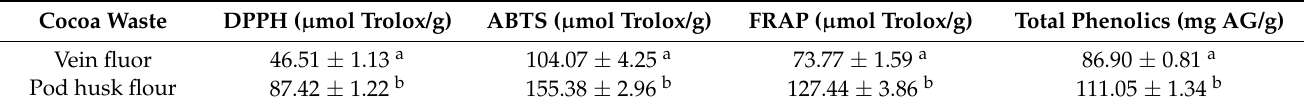
Table 6. Antioxidant activity of vein and pod husk flours of